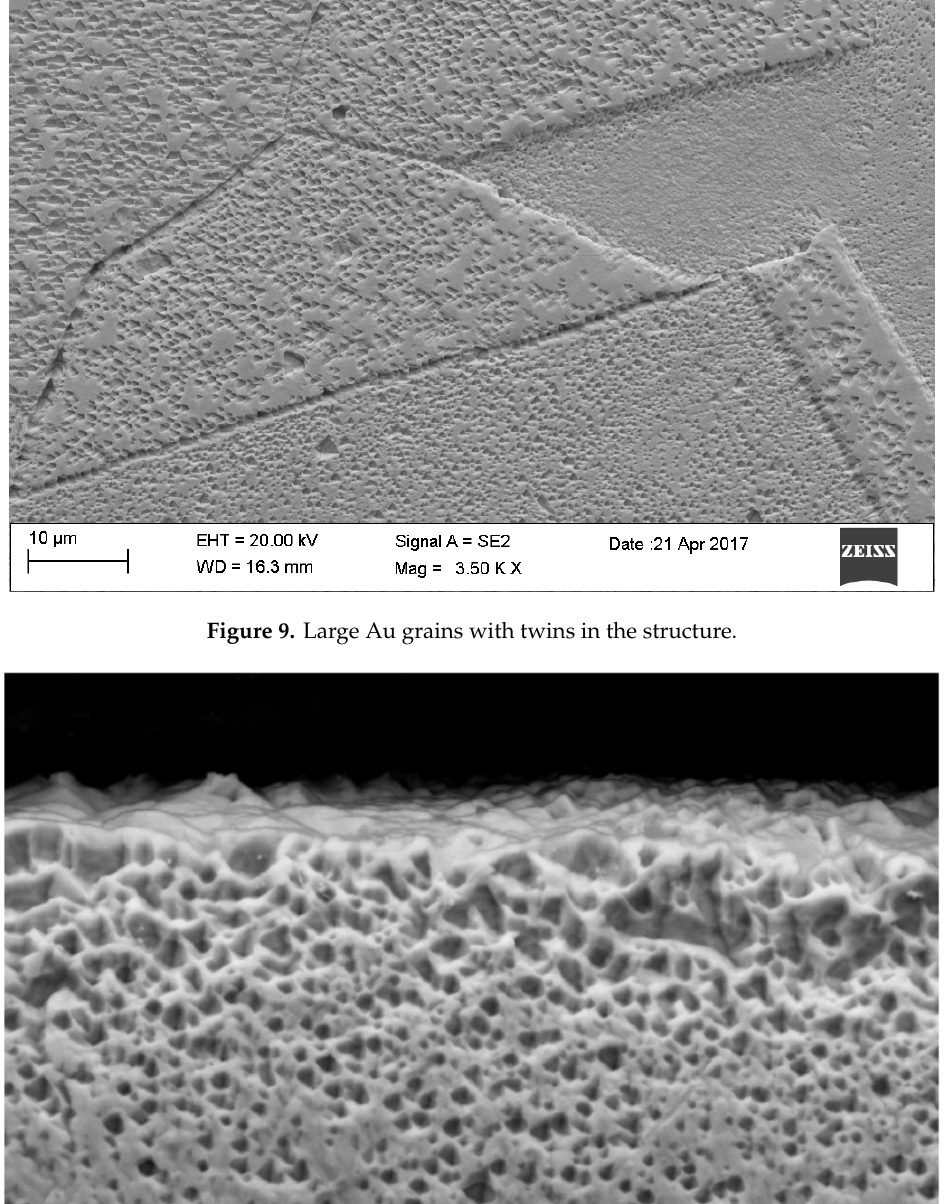
Figure 8. Results of point ( 1 ) and surface ( 2 ) microanalysis of the chemical composition of the coating layer on gold electrolytically deposited on copper. Table 1. Results of microanalysis of the chemical composition of the coating layer on a copper electrode with electrolytically-deposited gold. Element